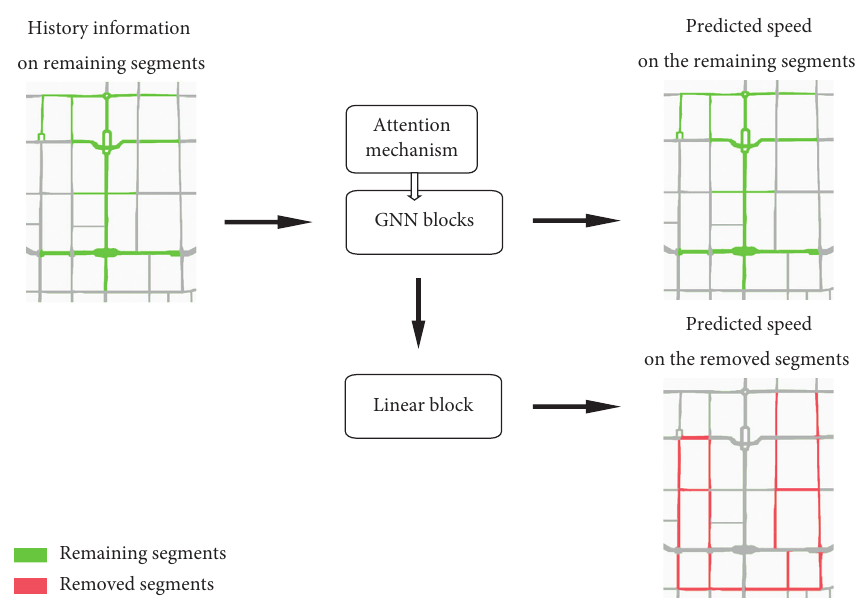
Figure 3: A graphical illustration of the proposed prediction model.